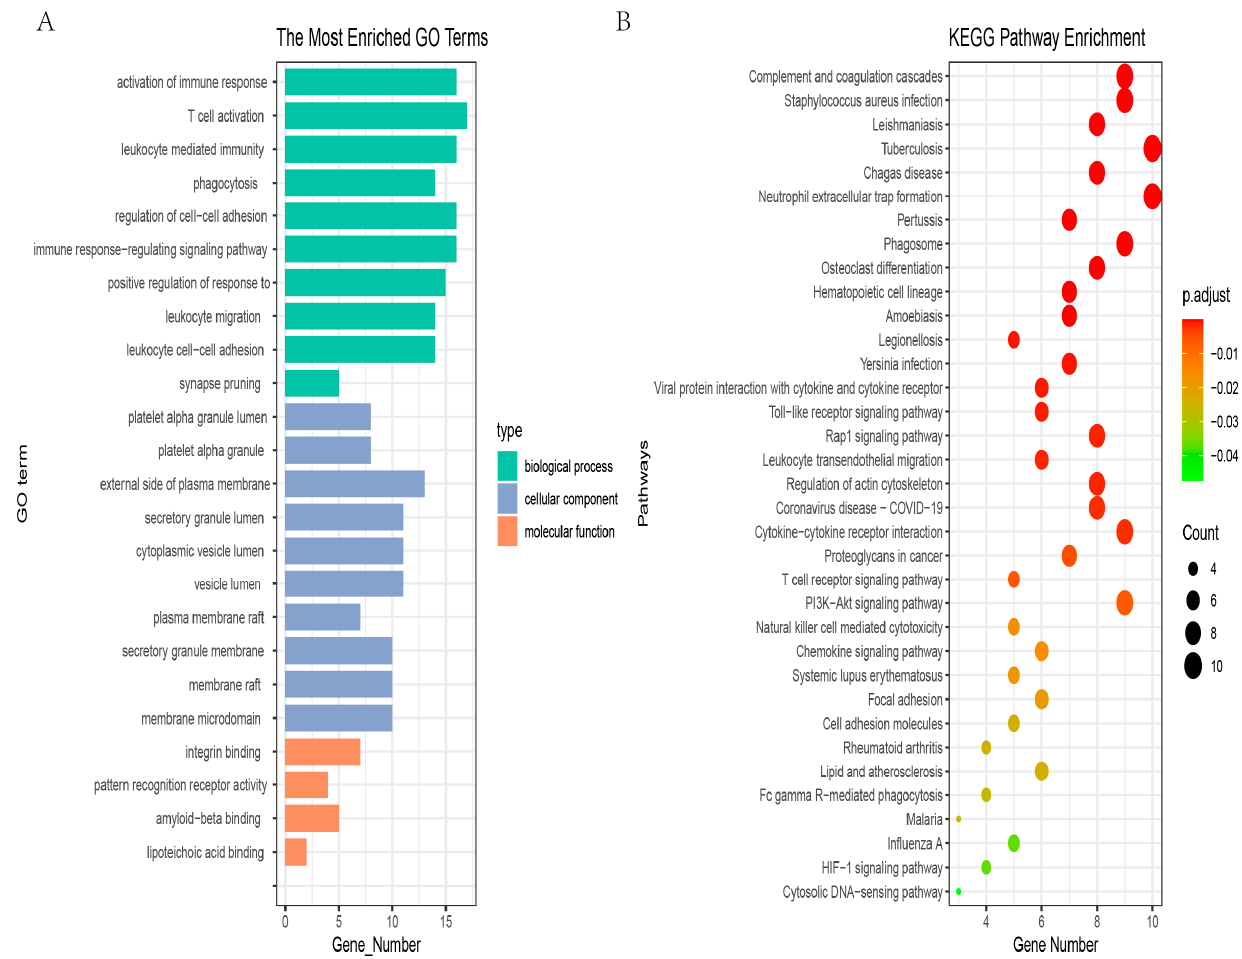
Figure 4. Gene Ontology (GO) and KEGG enrichment analyses of 82 candidate hub genes. ( A ) The top enriched terms of biological process, cellular component, and molecular function; ( B ) KEGG pathway mainly enriched in complement and coagulation cascades, Staphylococcus aureus infection, leishmaniasis, and tuberculosis.